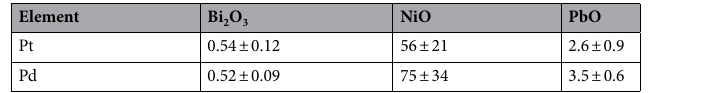
Table 4. Total procedure blanks (mean data ± standard deviation, n = 5) for Pt and Pd using commercially available Bi